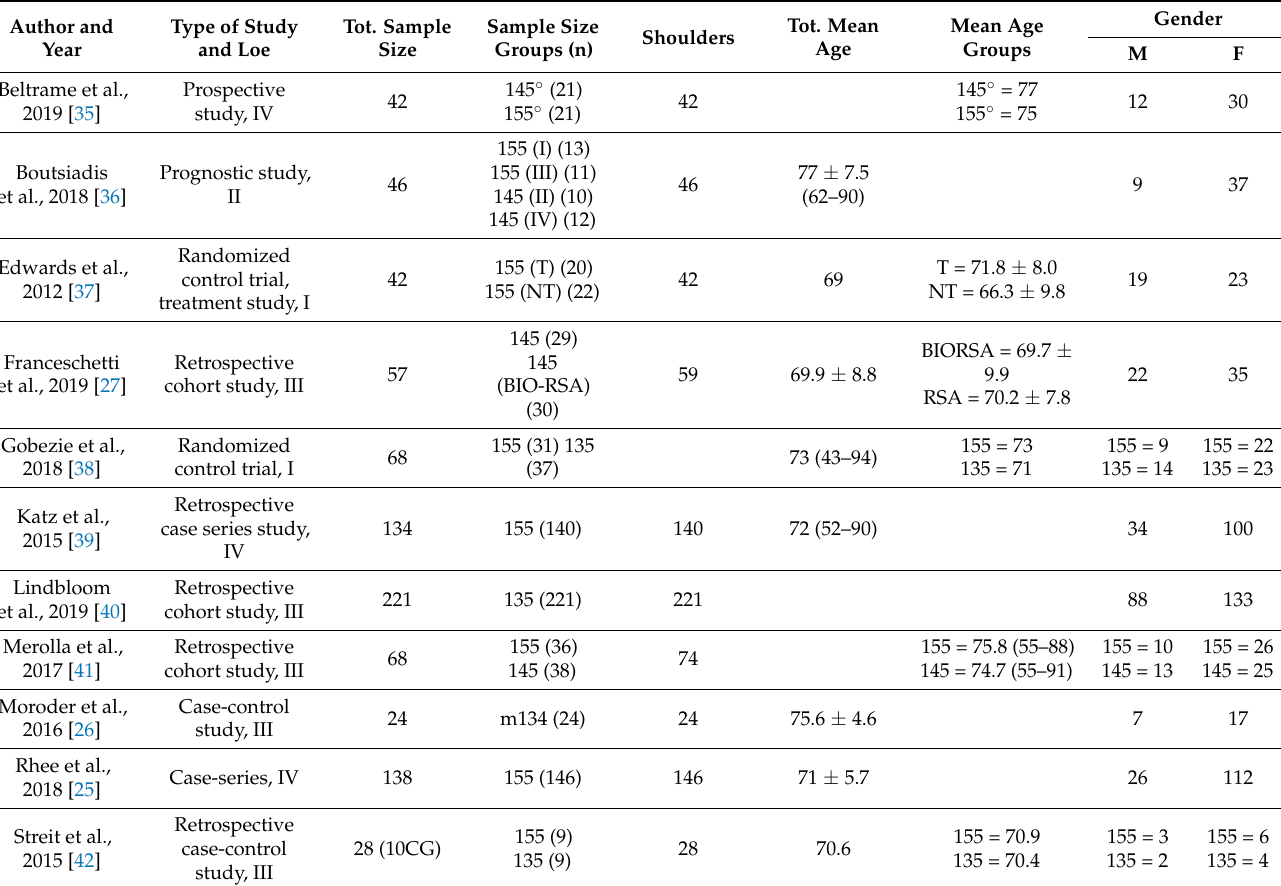
Table 1. Primary author, year of publication, type of study, level of evidence (LOE), sample size, mean age, gender totals, and number of shoulders treated of the studies included.